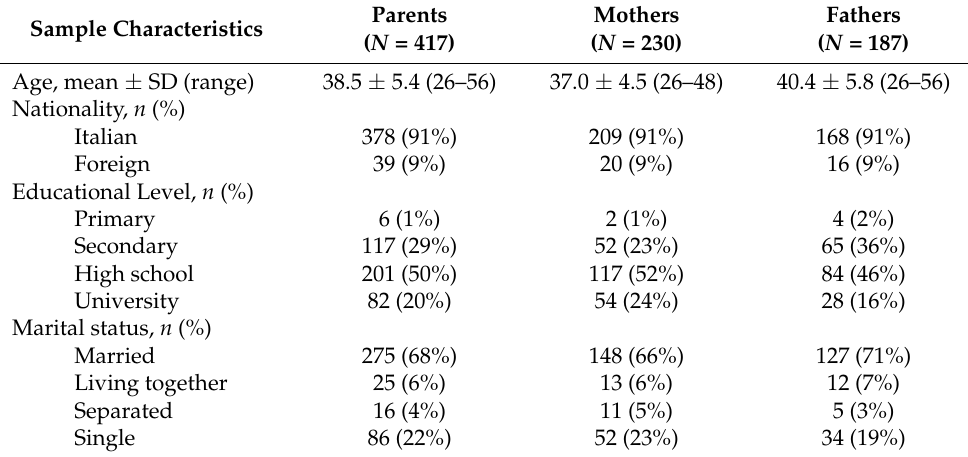
Table 1. Demographic characteristics of the sample. Sample